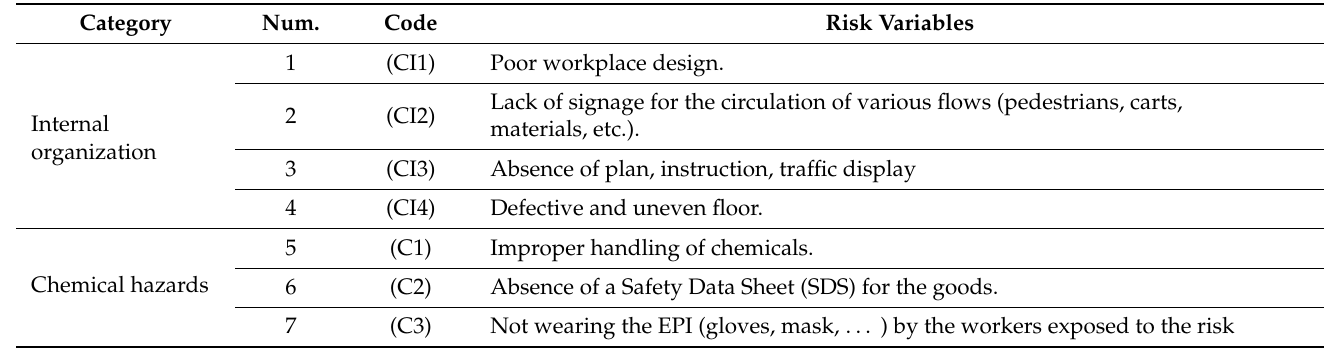
Table 1. The list of risk variables identified in Sfax seaport.